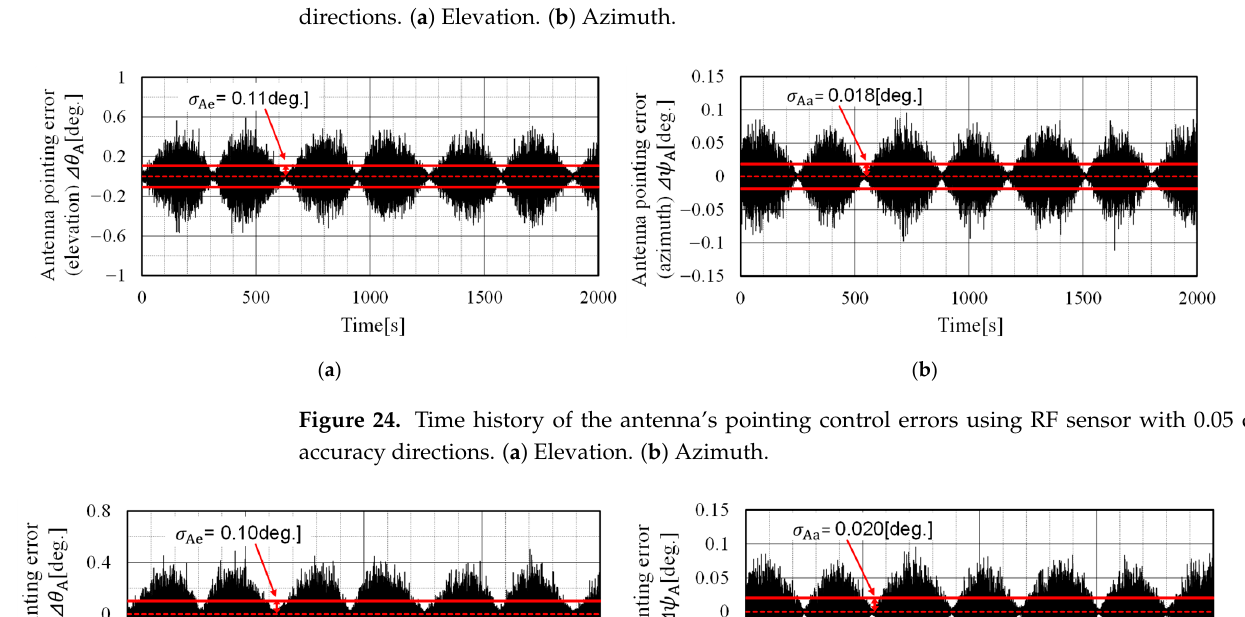
Figure 25. Time history of the antenna’s pointing control errors using RF sensor with 0.01 deg. ac-